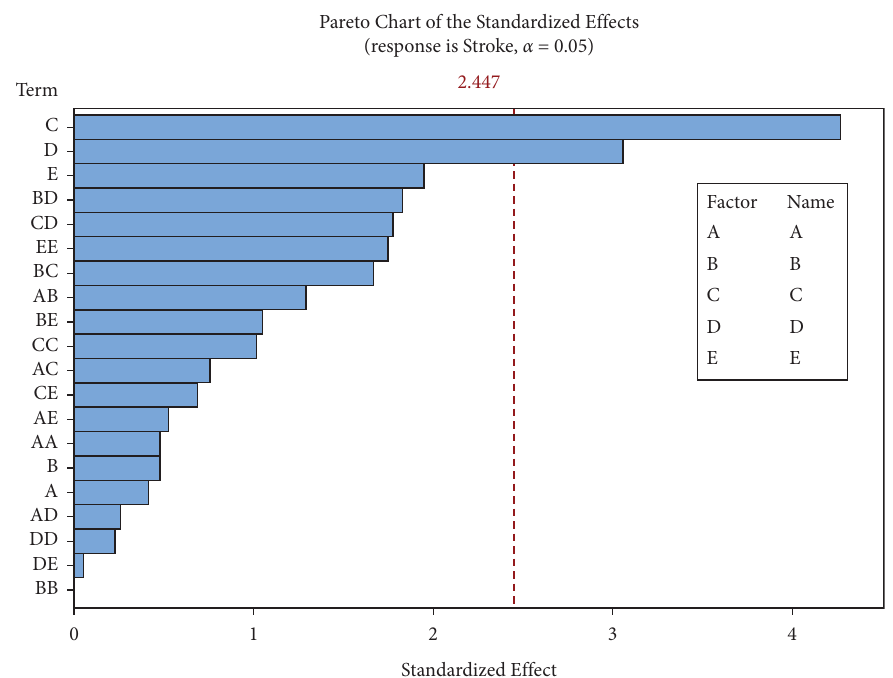
Figure 13: Sensitivity plot of design variables to the stroke. Table 7: Analysis of variance for safety